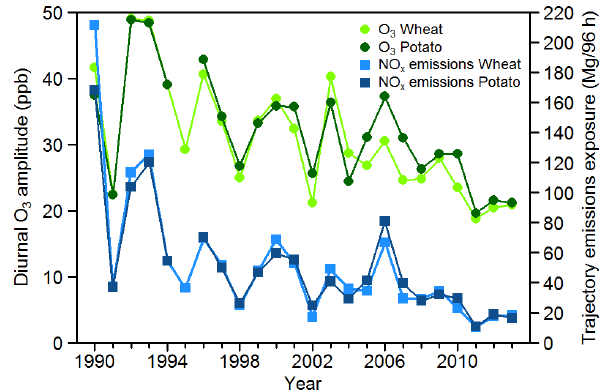
Figure 9. Amplitude of the diurnal O 3 cycle at Harwell during June POD Y accumulation days for wheat and potato and hourly Euro- pean NO x emission estimate for the EMEP 0.5 ◦ grids over which 96h back trajectories passed prior to arrival at Harwell during June POD Y accumulation days for wheat and